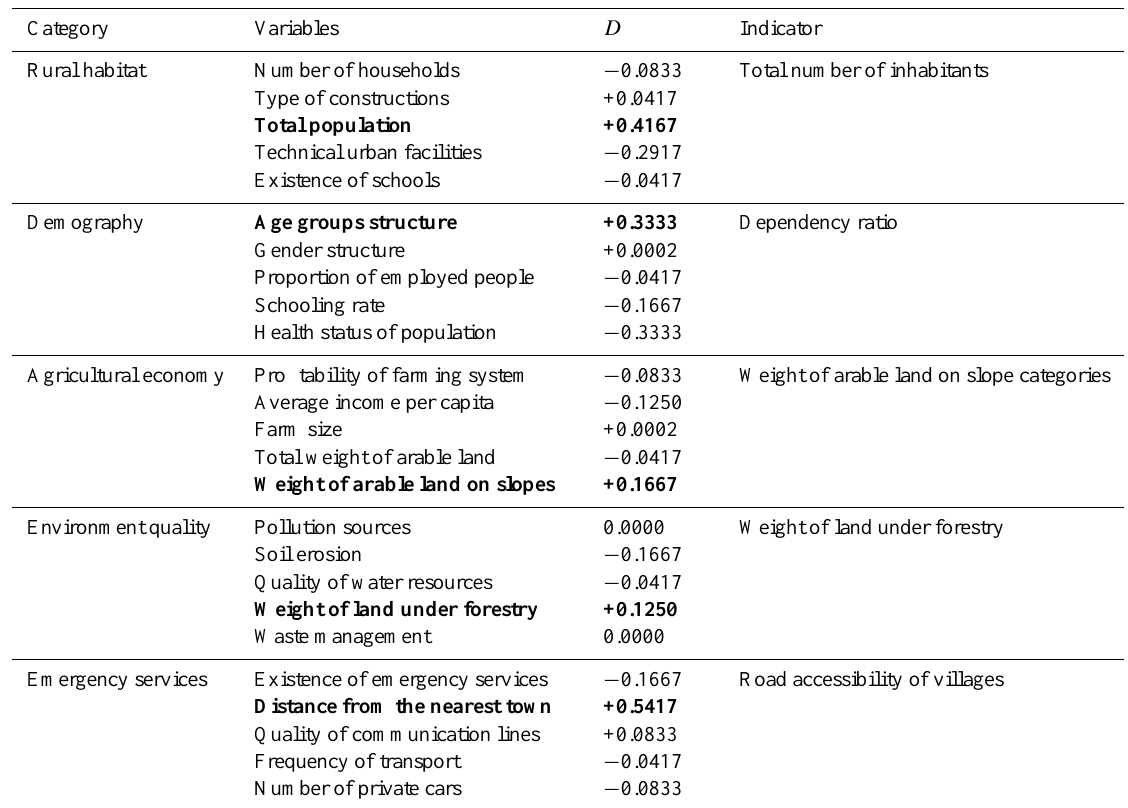
Table 1. Categories, variables and selected indicators for vulnerability assessment (with bold line: the highest values of each category and the selected